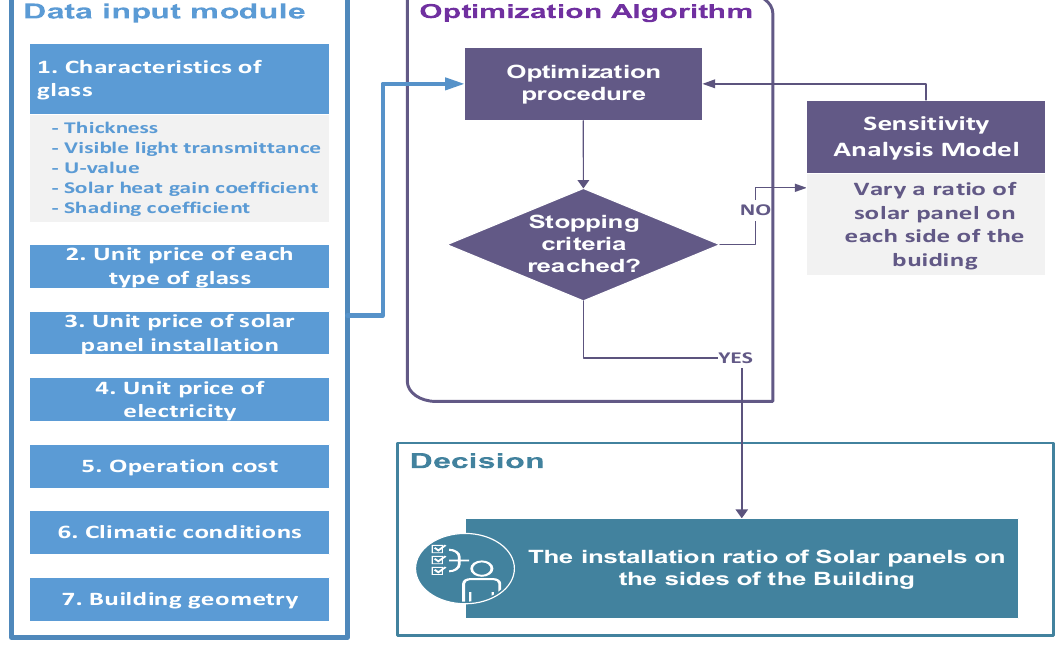
Figure 2. Decision ‐ making support optimization model. Figure 2. Decision-making support optimization